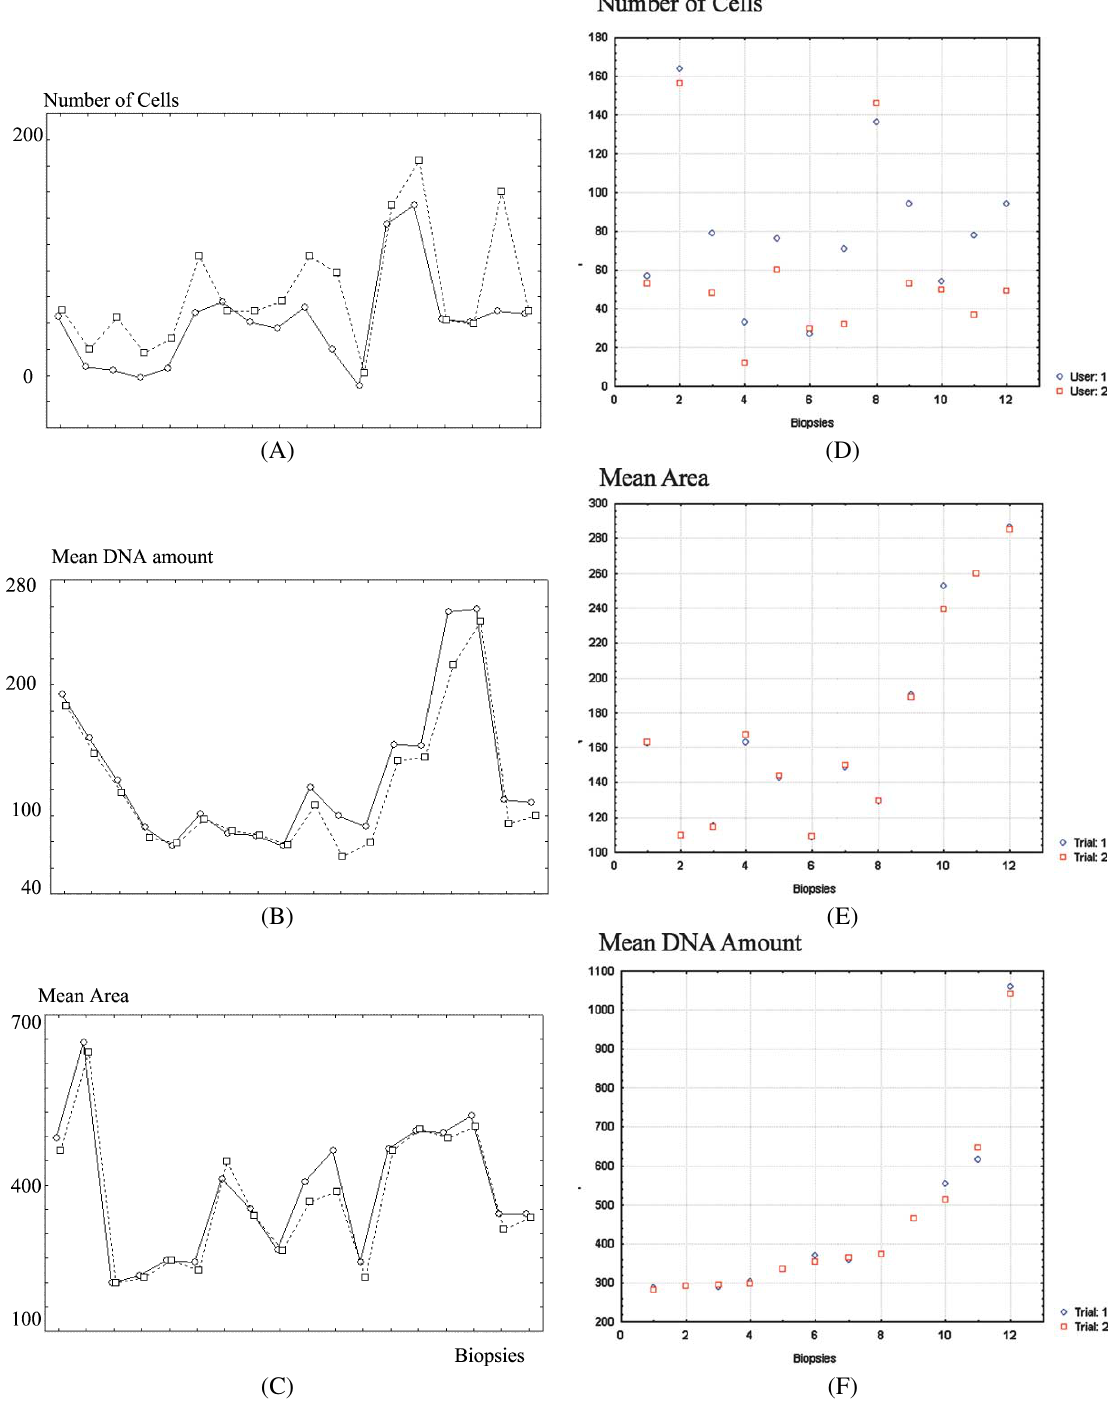
Fig. 3. Inter-observer and Intra-observer Variability (2 users). A: Number of cells collected: inter-observer variability. B: Mean DNA amount of the epithelial cells: inter-observer variability. C: Mean area measured of the epithelial cells: inter-observer variability. D: Number of cells collected: intra-observer variability. E: Mean area of the epithelial cells: intra-observer variability. F: Mean DNA amount of the epithelial cells: intra-observer